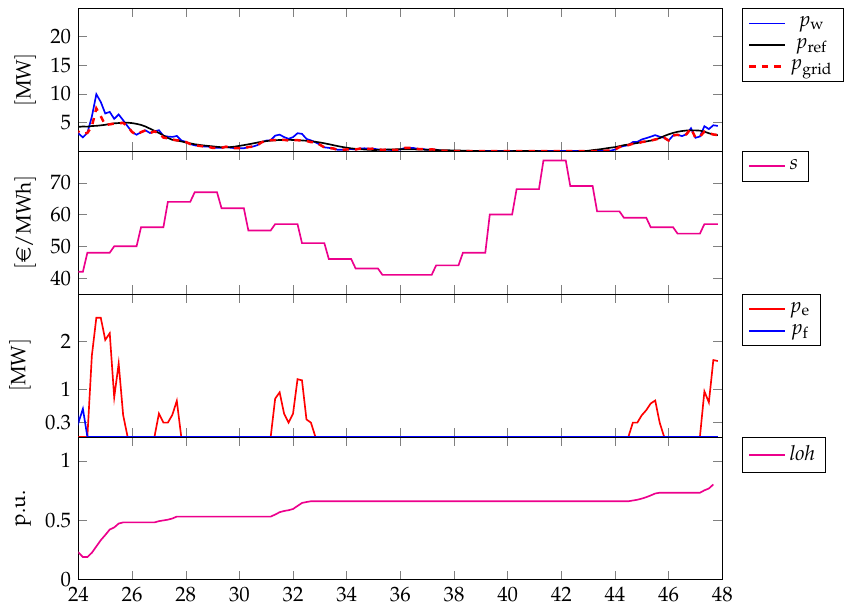
Figure 10. Different profiles related to the reference period from 14:40 of 19 February 2017 to the same hour of 20 February 2017, with full-feature operations. First graph: power by wind generation (blue line), power reference that has to be delivered to the grid (black line) and actual power delivered (dashed red line); Second graph: spot market prices s (source: “Gestore dei Mercati Energetici s.p.a. — www.mercatoelettrico.org”); Third graph: power of the electrolyzer (red line) and power of the fuel cell (blue line); Fourth graph: LoH.